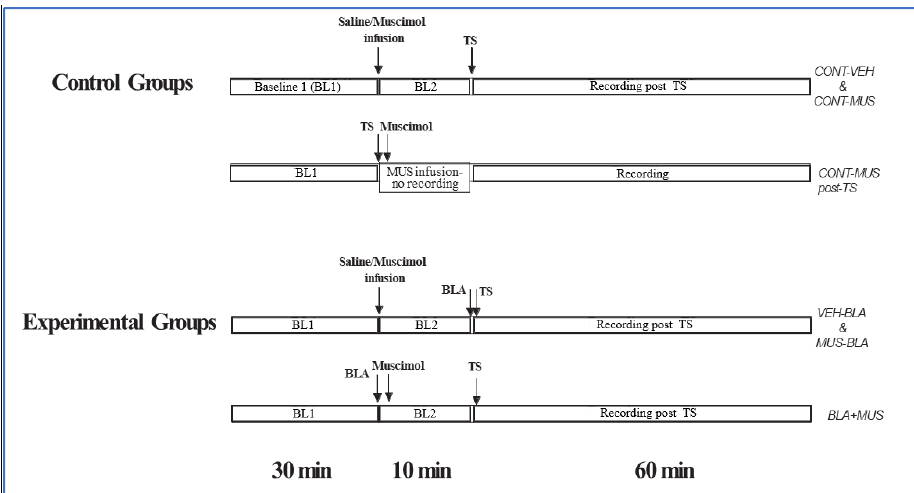
Figure 5. Experimental protocol: The effect of modulating basolateral amygdala (BLA) GABAergic transmission on long-term potentiation (LTP) in ventral hippocampal commissure (vHC)-CA1 and perforant pathway (PP)-dentate gyrus (DG) pathways was examined in two ways: 1. muscimol injection to the BLA without priming the BLA prior to LTP induction in the hippocampus (control groups), and 2. combining muscimol injection and BLA priming (experimental groups) (See Materials and Methods).